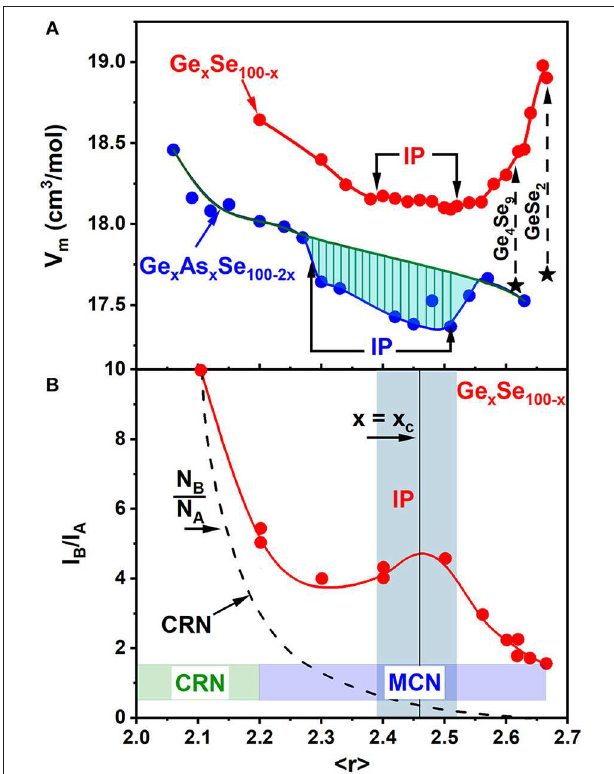
FIGURE 14 | (A) Trends in molar volumes, V m (x) of binary Ge x Se 100 − x glasses compared to those of the present Ge x As x Se 100 − 2x ternary glasses. (B) 129 I Mössbauer site intensity ratios I B /I A (x), deduced from doping 129m Te tracer in Ge x Se 100 − x glasses reveal a Continuous Random network (CRN) type of a variation at low x ( < 10%). But at higher x ( > 15%) a Molecular Clustered Network (MCN) prevails as the observed site intensity ratios I B /I A (x) far exceed the expected N B /N A (x) site concentration ratio based on a CRN (Bresser et al., 1986). See text. Also note that as x increases to 33.3% of Ge, the finite value of the I B /I A ratio of 1.66 (10) shows the stoichiometric GeSe 2 glass has an intrinsically broken chemical order (Bresser et al.,